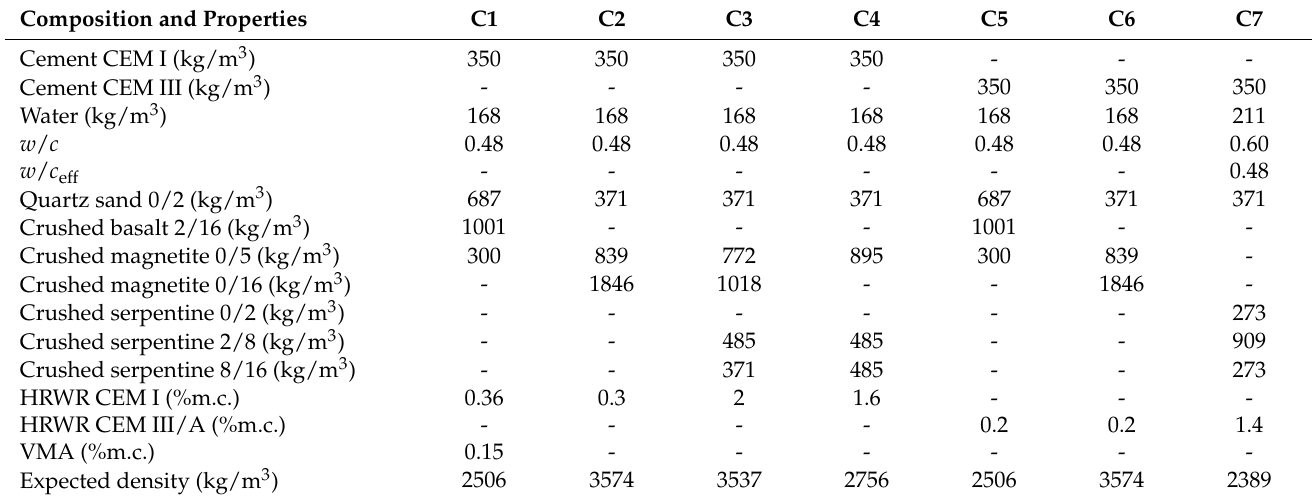
Table 3. Concrete mixtures compositions and